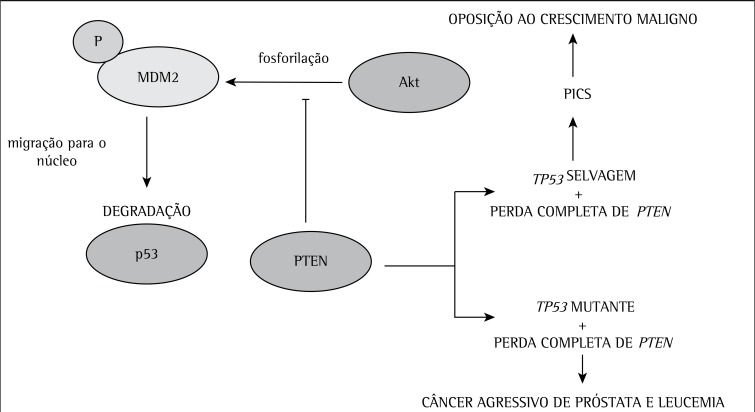
A proteína phosphatase and tensin homolog (PTEN, homólogo de tensina
e fosfatase) protege a p53 da degradação mediante a inibição da migração
da proteína murino duplo minuto 2 (MDM2) para o núcleo. Existe um
mecanismo cross-talk entre PTEN e p53. Quando ocorre a completa perda de
PTEN associada a um TP53 selvagem resulta em um mecanismo de senescência
denominado PTEN loss induced cellular senescence (PICS, senescência
celular induzido por perda do PTEN), o qual é um importante mecanismo de
oposição ao crescimento maligno. A perda de PTEN em um contexto celular
com um TP53 mutante tem como consequência um câncer mais agressivo de
próstata e leucemia, sendo ambos os mecanismos até o momento demonstrados
em animais.